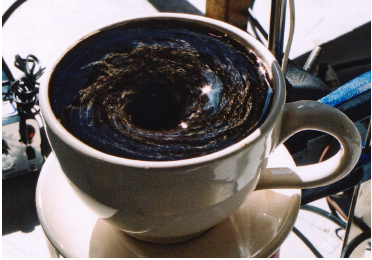
Figure 4. An example of a familiar vor- tex. The position of the vortex is charac- terised by the line running along the cen- tre of the